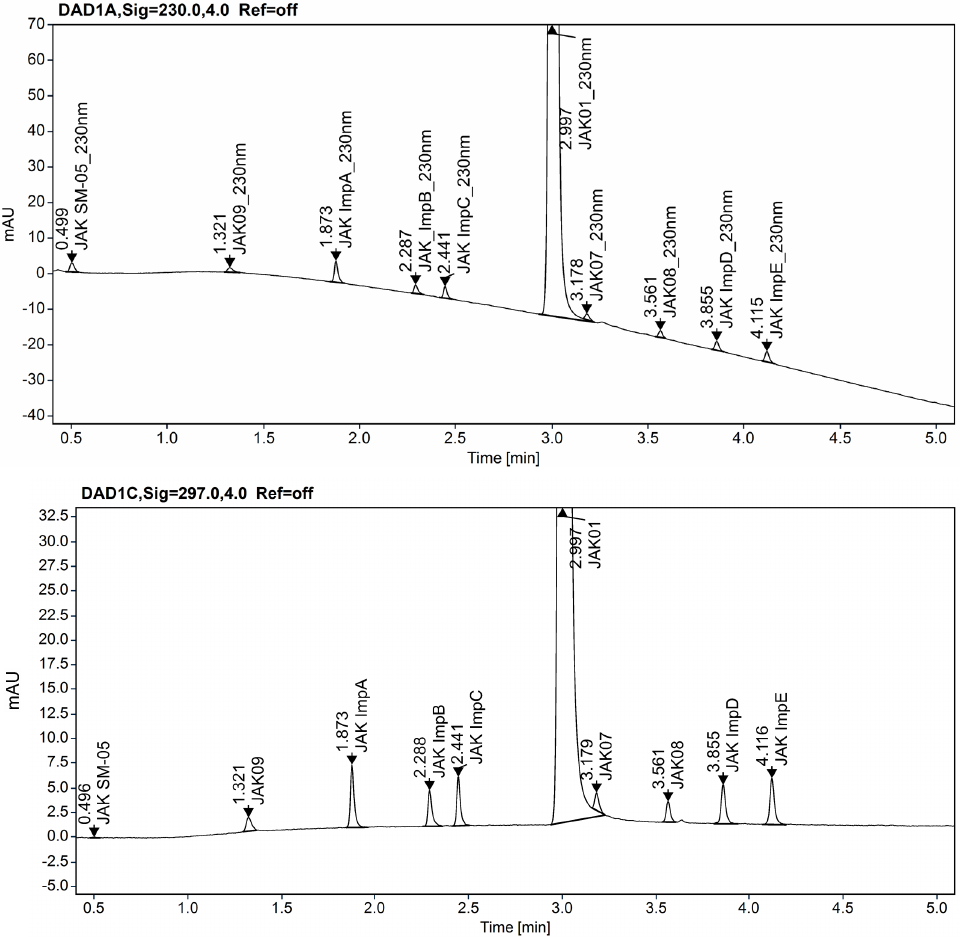
Figure 7. Chromatogram of JAK01 substance solution spiked with impurities at 0.15% level on the Kinetex EVO C18 (2.1 × 50 mm, 1.7 µ m, Phenomenex)